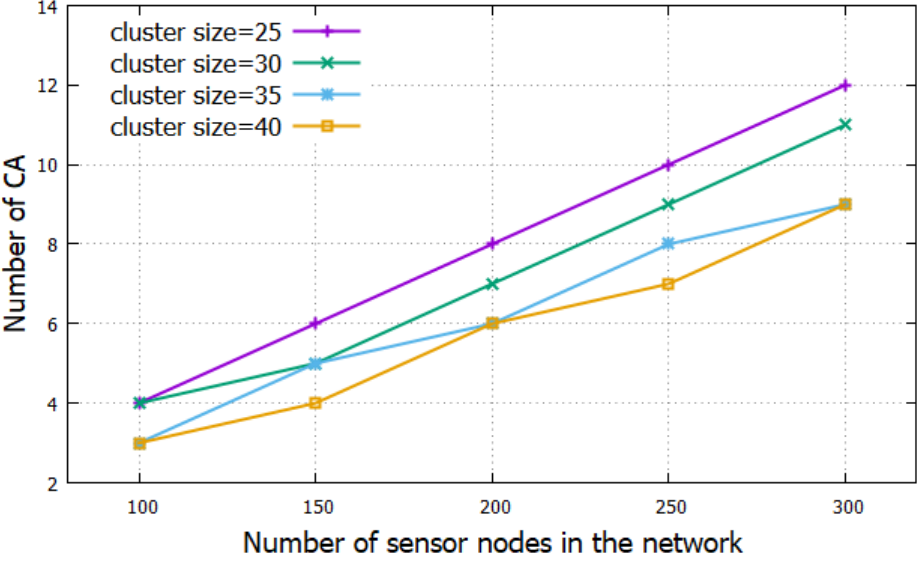
12 Table 2. The simulation parameters. Parameters